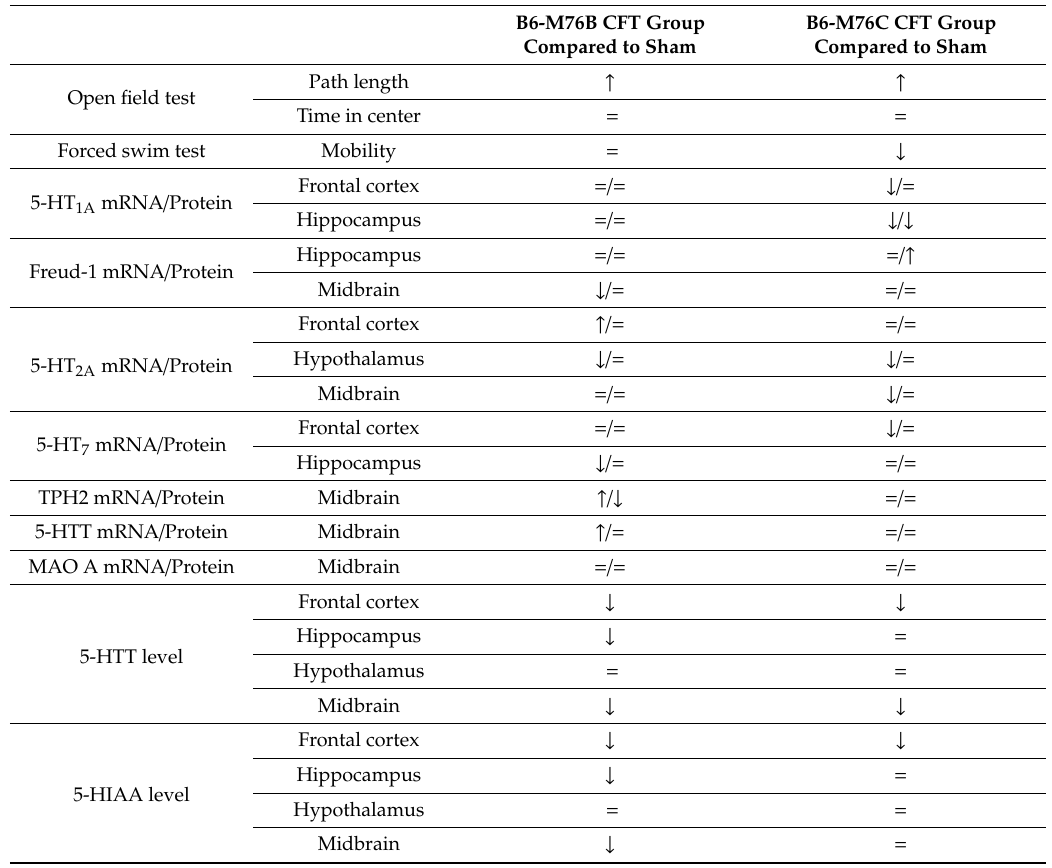
Table 1. Summary of the obtained